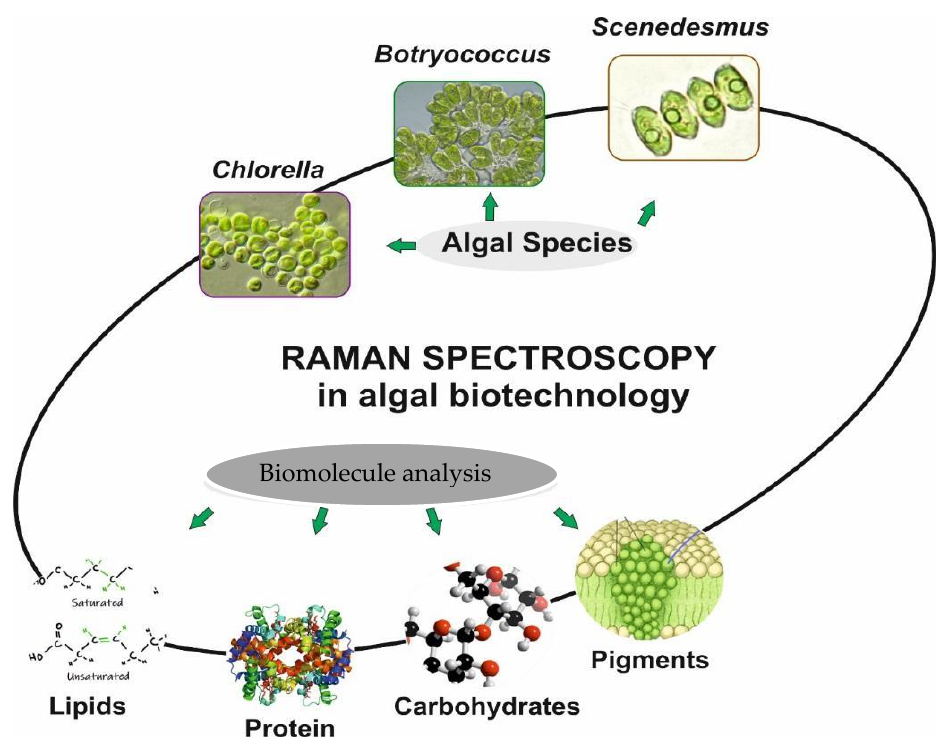
Figure 5. A schematic of the experimental set-up of a typical Raman spectrometer and schematic showing applicability of RS to different aspects of algae.